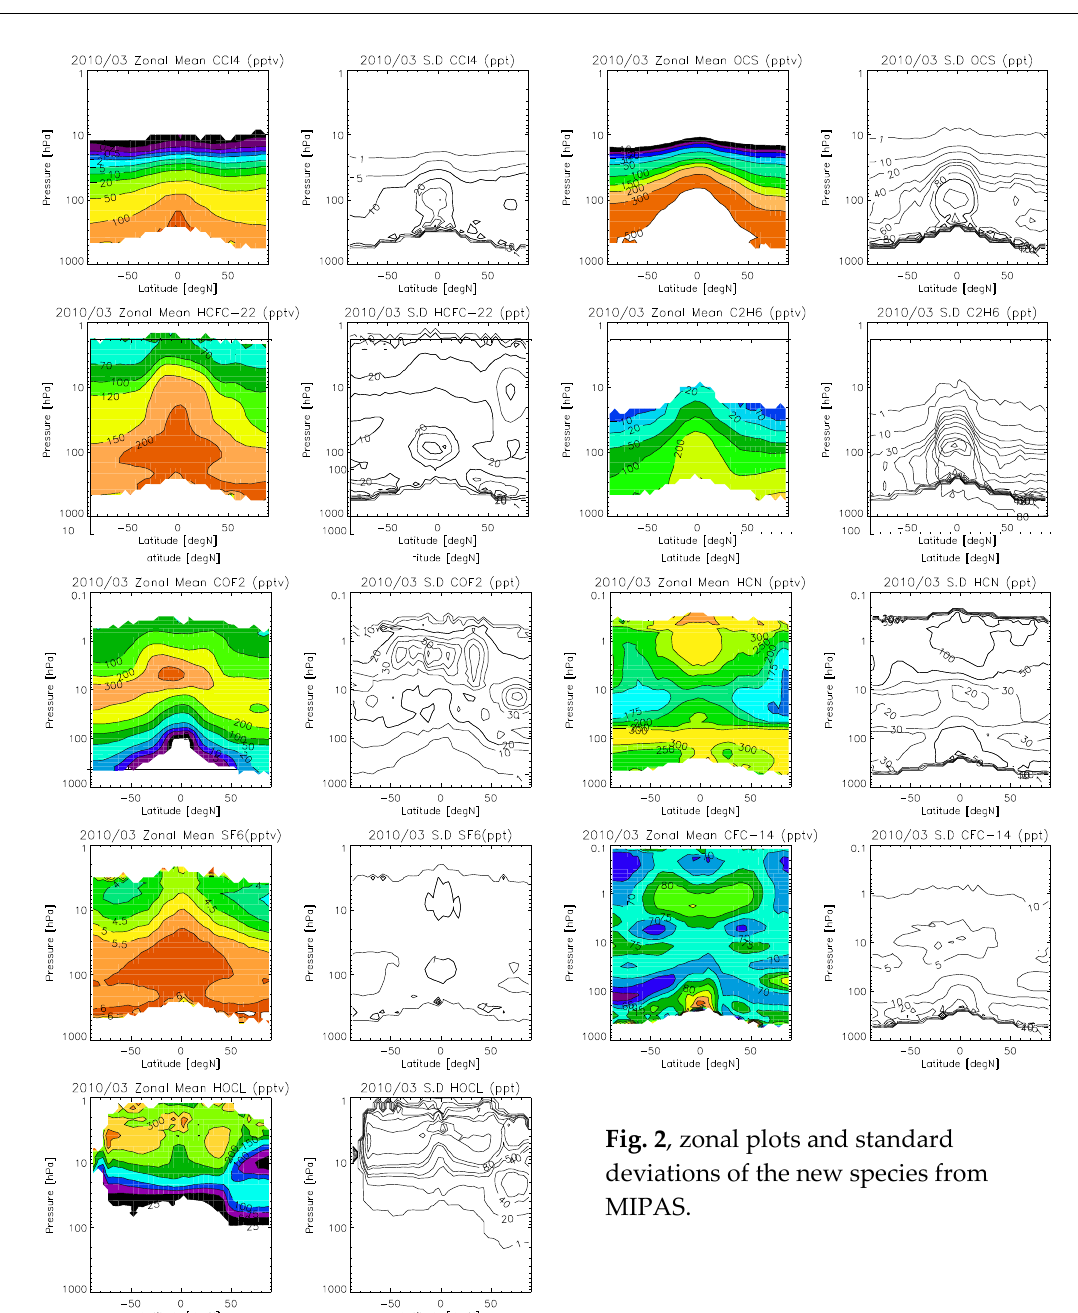
plot of COF 2 also well represents the maxi- mum of VMR around the middle of the stra- tosphere over equator. This occurs because